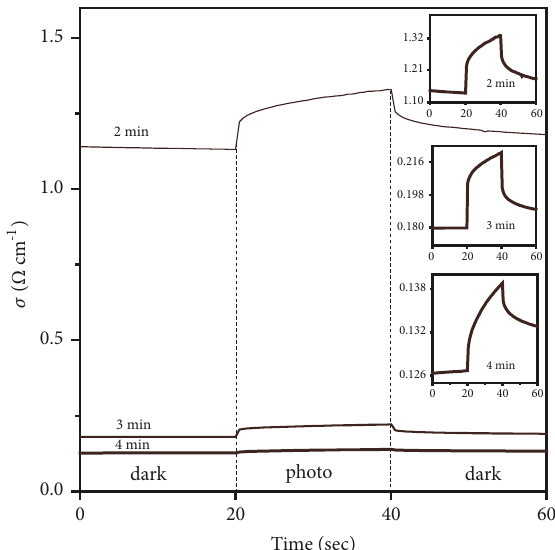
Figure 6: Electrical conductivity of PbS thin films. Inset shows the photoconductivity rise and